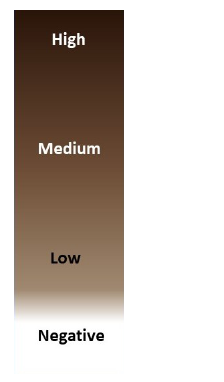
Figure 1. Labels and corresponding description for each one of the classes considered according to Wnt-1 intensity at pixel levels, four quarterlies are